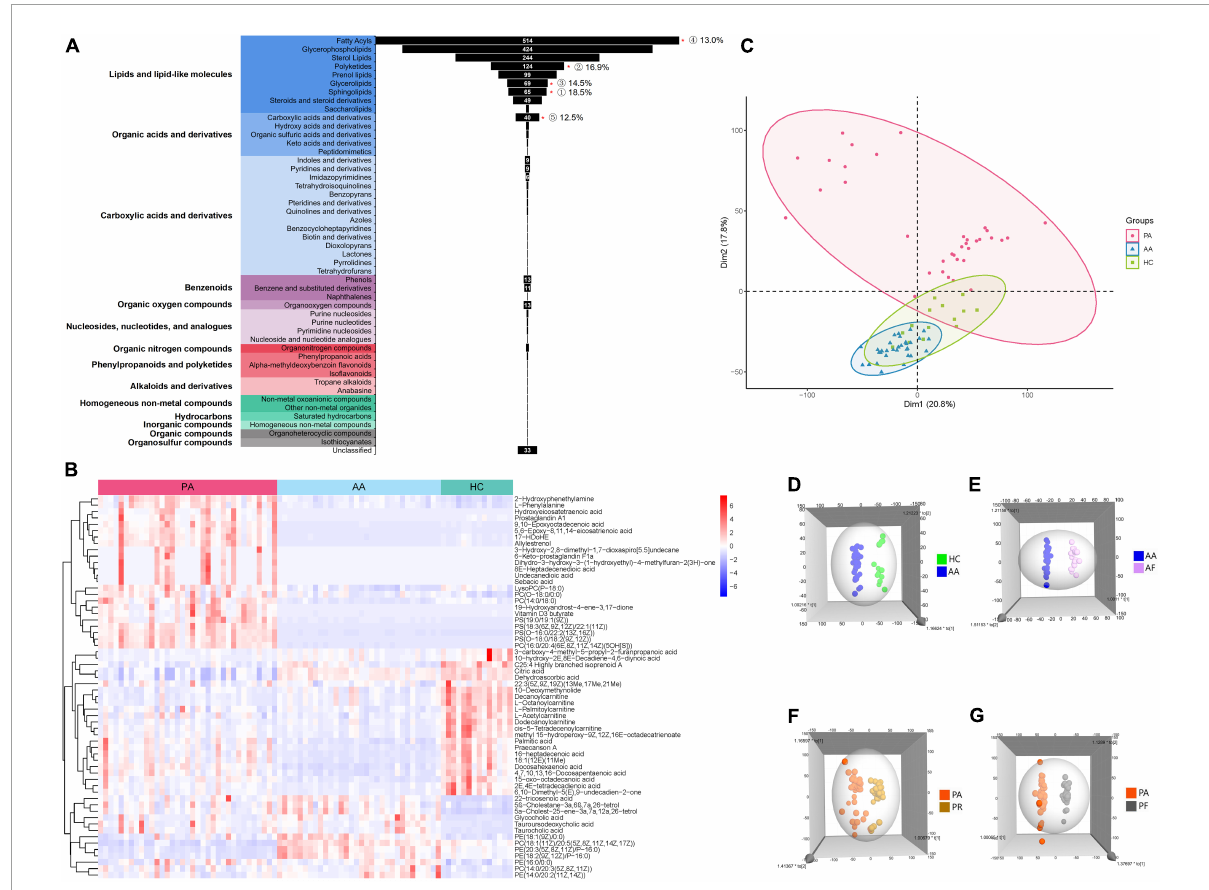
FIGURE1 Analysis of untargeted metabolomics between cases and healthy controls. (A) Shows the classification of all metabolites that were screened. “*” p < 0.05; the number of % represent for the ratio of the number of differential metabolites with P < 0.05 to each class. (B) Shows the clustering results of the metabolites at the top 60 of VIP among PA, AA, and HC. (C) Shows the PCA of samples from the three groups. (D) Shows the 3D OPLS-DA scatter plot for HC and AA. (E) Shows the 3D OPLS-DA scatter plot between AA and AF. (F) Shows the 3D OPLS-DA scatter plot between the PA and PR. (G) Shows the 3D OPLS-DA scatter plot between PA and PF. PA, patients in the acute stage; AA, asymptomatic cases at the acute stage; HC, healthy controls; AF, asymptomatic cases at the follow-up stage; PR, patients at the recovery stage; PF, patients in the follow-up